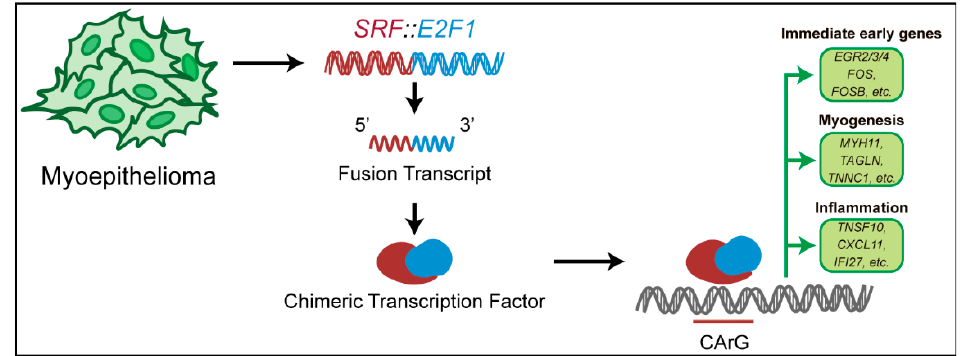
Figure 8. Schematic representation of the proposed pathways involving SRF::E2F1 . In SRF fusion- positive myoepitheliomas, the SRF::E2F1 fusion encodes a chimeric transcript, and consequently, an aberrant transcription factor is produced. The chimeric protein binds the CArG sequence on the DNA, inducing the expression of immediate early genes and those involved in myogenesis and inflammation.